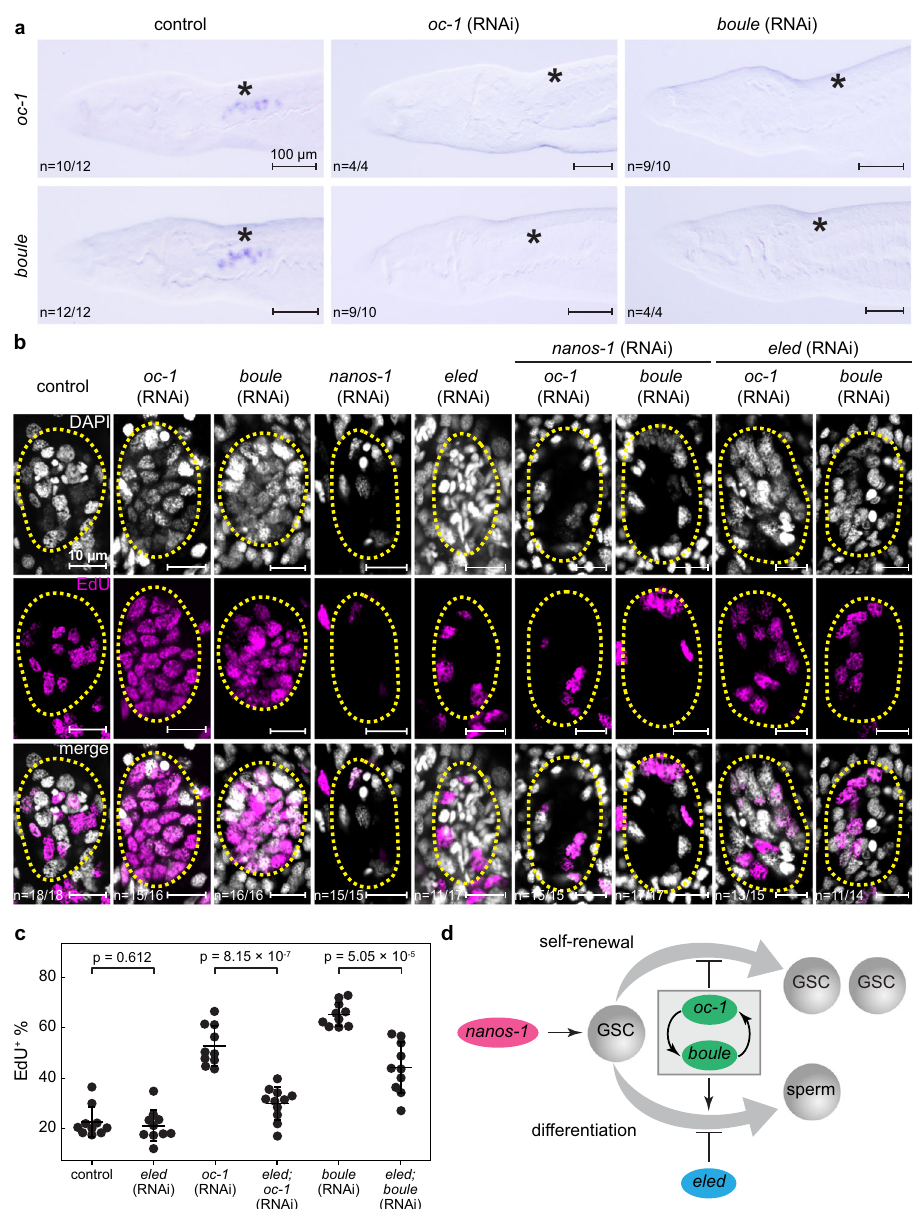
Fig. 5 Epistatic interactions of oc-1 , boule , nanos-1 , and eled . a WISH images showing that the expression of oc-1 and boule are mutually dependent. Knockdown of either one causes the elimination of both. Asterisks: testes. b Confocal images showing representative individual testis lobules stained by DAPI and EdU in juvenile parasites after RNAi treatments. Dashed circles: testis lobule boundary. n : number of samples exhibiting the reported phenotype out of the total number of samples analyzed. c Fraction of EdU + nuclei in testes in control and RNAi parasites. Each data point represents the average across all testis lobules in a single parasite. N = 10 (control RNAi); N = 10 ( eled RNAi); N = 10 ( oc-1 RNAi); N = 11 ( eled ; oc-1 RNAi); N = 10 ( boule RNAi); N = 10 ( eled ; boule RNAi). nanos-1 RNAi experiments were not quanti fi ed because only a few GSC nuclei are present per testis lobule, which is insuf fi cient for reliable statistics. Data are plotted as average ± standard deviation and p -values are calculated using two-sided Welch ’ s t -test. RNAi experiments were repeated on at least three biological replicates. d Proposed model of genetic interactions between oc-1 , boule , nanos-1 , and eled in regulating male GSC identity, proliferation, and